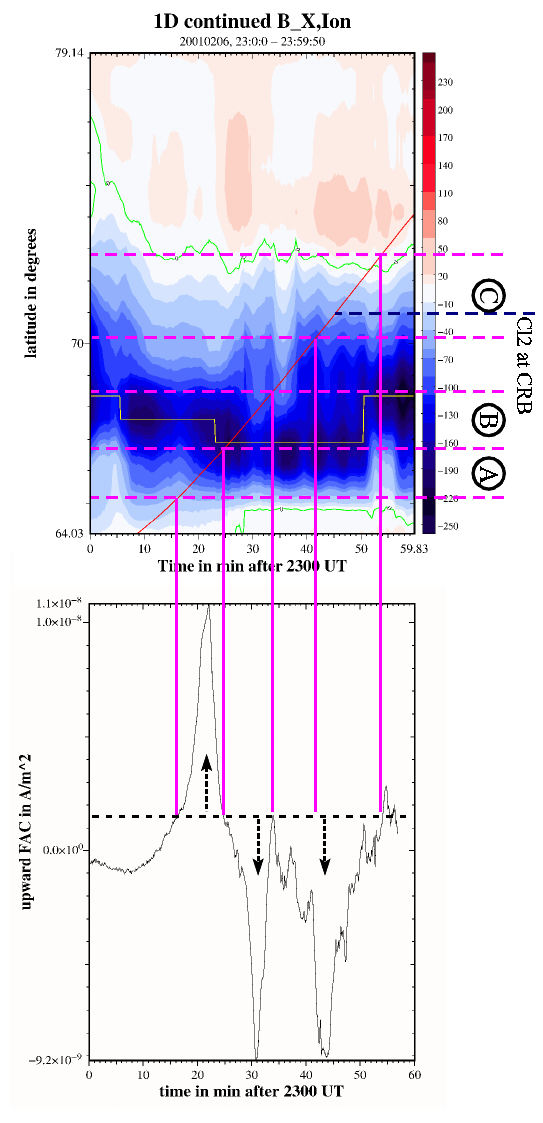
Fig. 9. Topology of the FAC regions as observed by Cluster space- craft 2 (lower panel, as in Fig. 7) in terms of the magnetic field on the ionospheric level (upper panel, as in Fig. 3, left